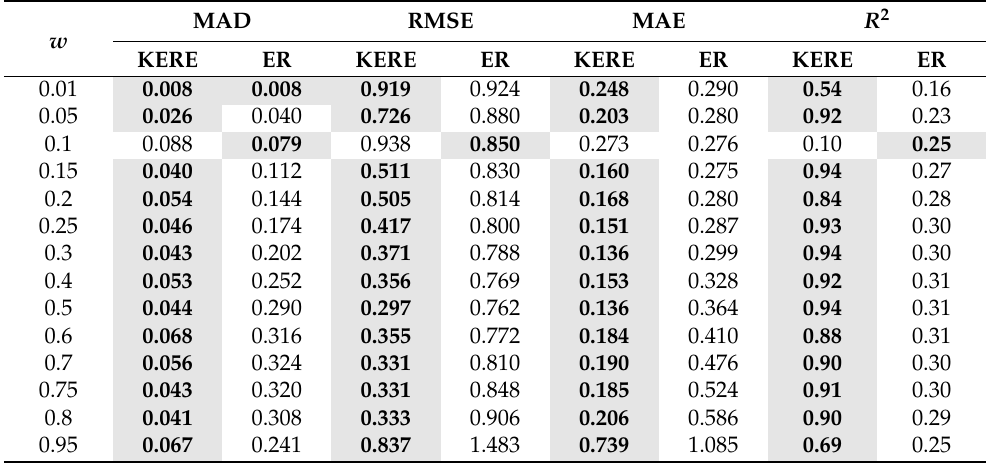
Table 3. Direct emissions. The training MAD, RMSE, and MAE metrics for both KERE and ER are reported with respect to the various expectile levels ranging between 0.01 and 0.99. MAD RMSE MAE R 2 w ER